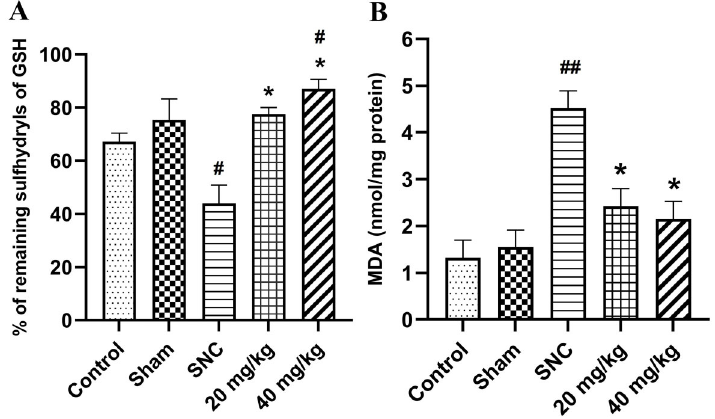
Figure 1. Effects of pinostrobin (PB) treatment (20 and 40 mg/kg) on reduced glutathione (GSH) sulfhydryls ( A ) and malondialdehyde (MDA) ( B ) levels after 28 days of sciatic nerve crush (SNC) injury. Data are reported as means ± SE (n=6). *P o 0.05 vs SNC group; # P o 0.05 and ## P o 0.01 vs control group